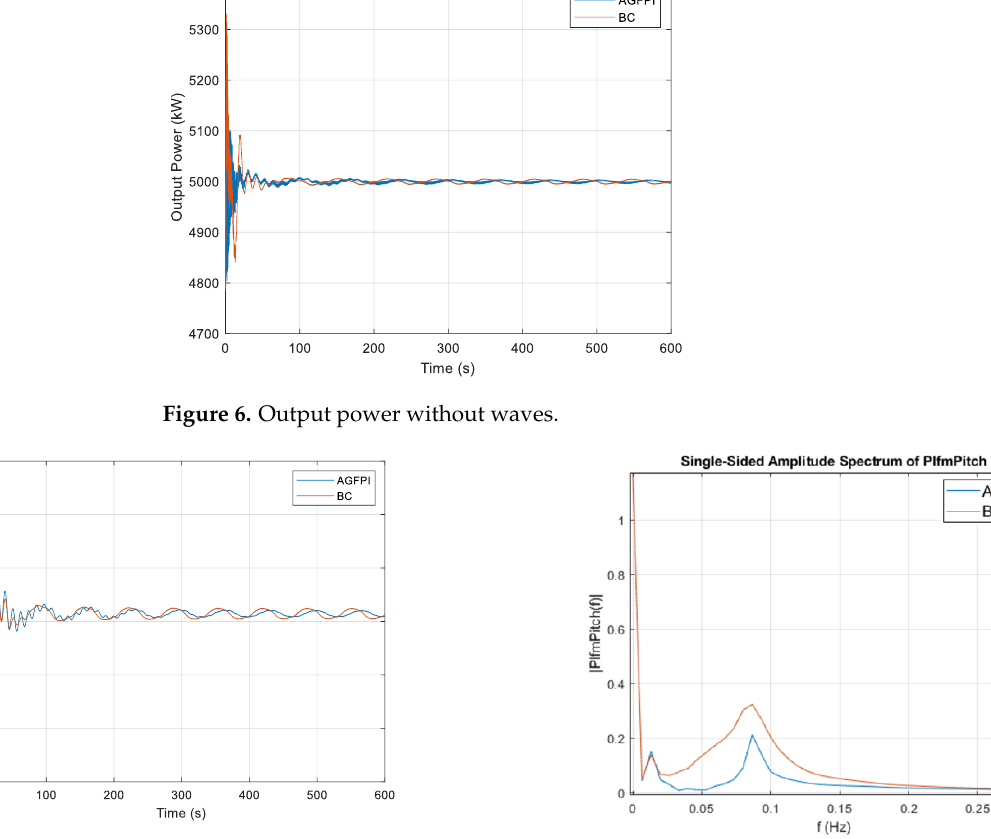
Figure 7. Platform pitch without waves ( left ) and its single side amplitude spectrum ( right ).